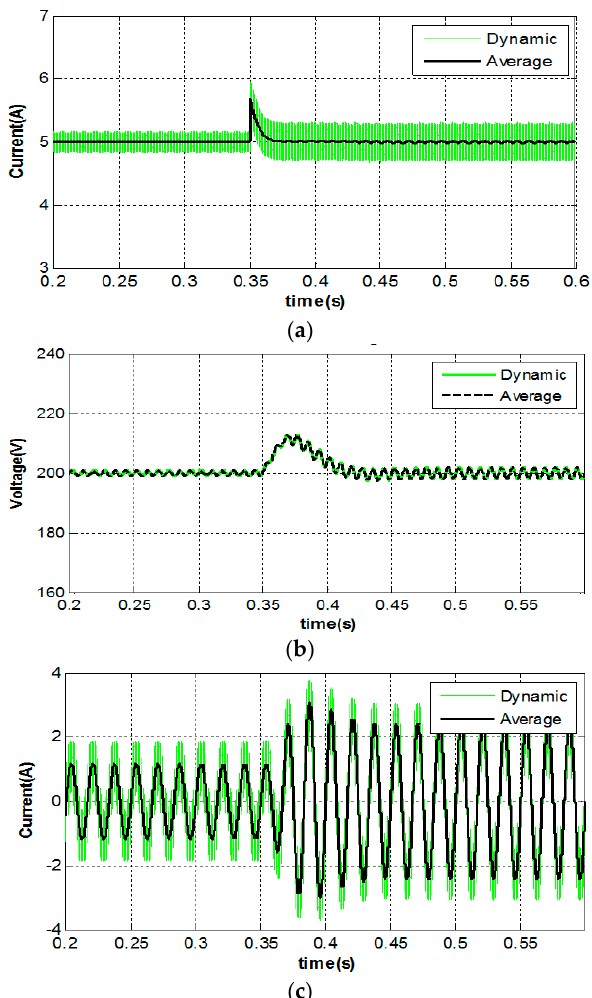
Figure 11. Simulation results with closed-loop control. ( a ) PV currents; ( b ) dc-bus voltage; ( c ) ac output current.